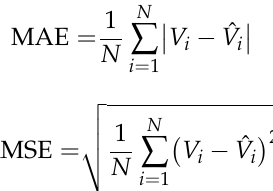
Figure 11. The battery terminal voltage of the CC discharge test and the relative error for the three